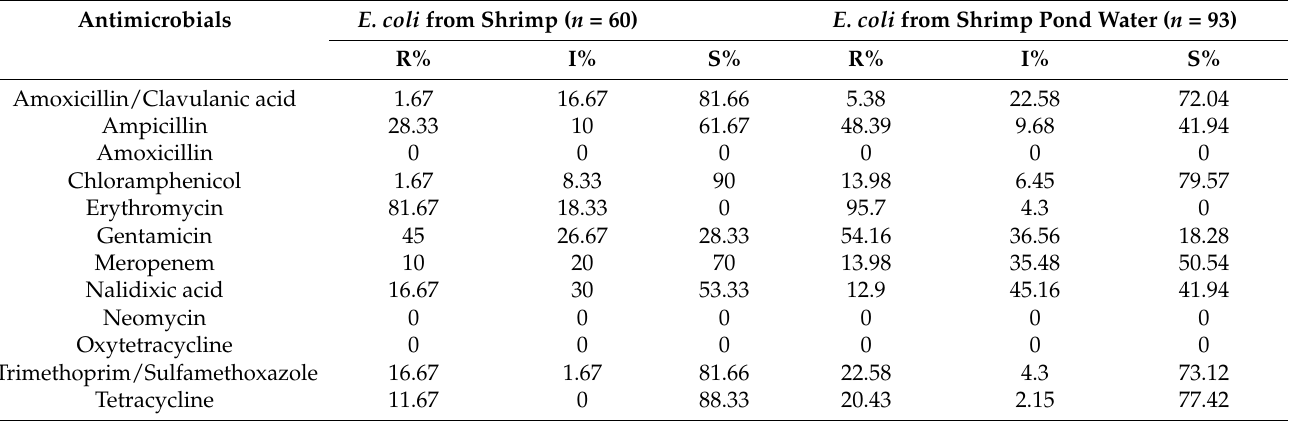
Table 3. Susceptibility/resistance of E. coli isolated from shrimps and E. coli isolated from shrimp culture pond water.